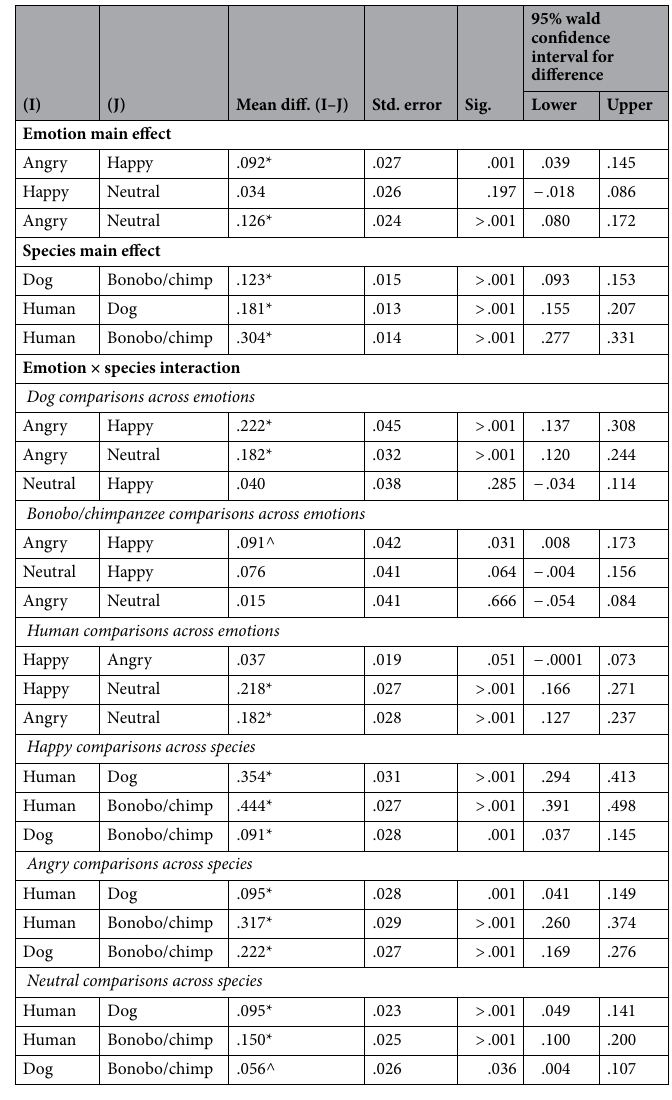
Table 2. Main effects and interaction on accuracy of emotion inferences across species and emotions in Study 2. *significant at Bonferroni corrected p < .0021; (^) marginally